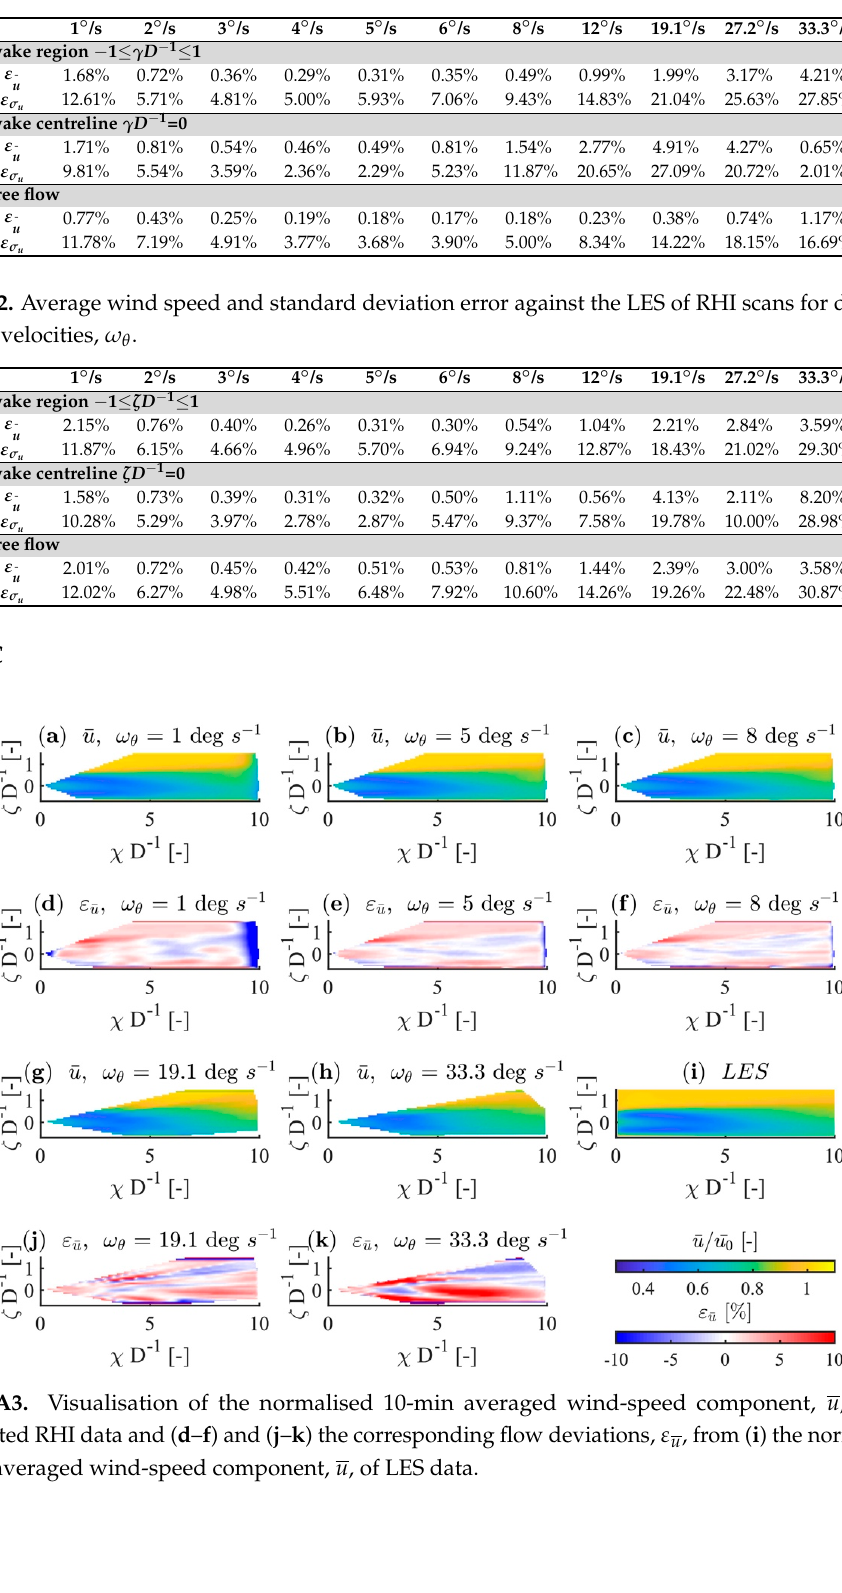
Table A1. Average wind speed and standard deviation error against the LES of PPI scans for different angular velocities, ω φ .